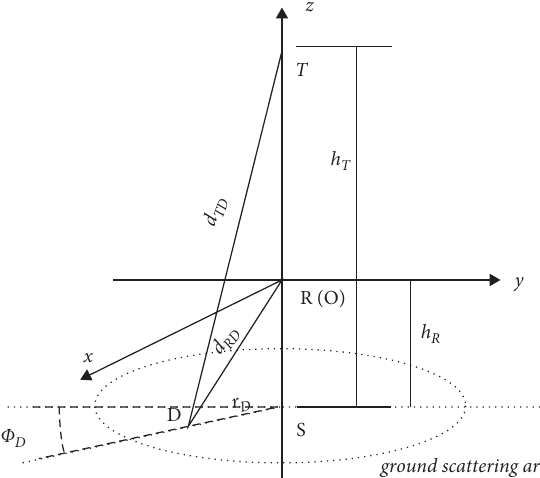
Figure 2: The geometrical structure of the VPS.